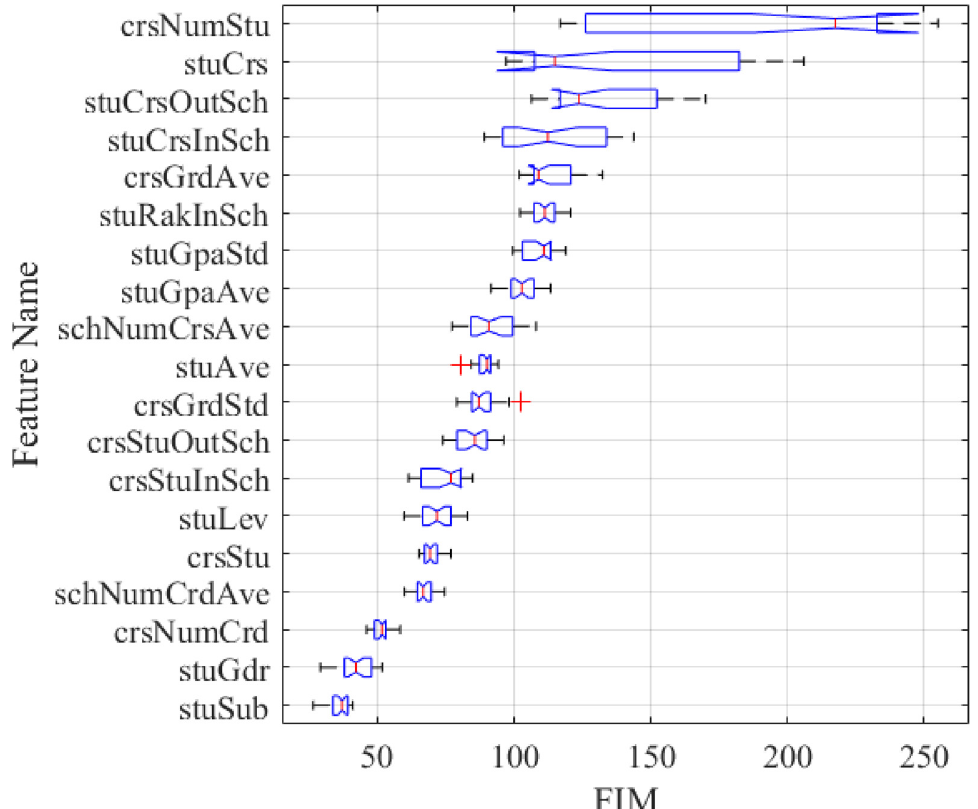
Fig 8. Box plots of FIMs for all the